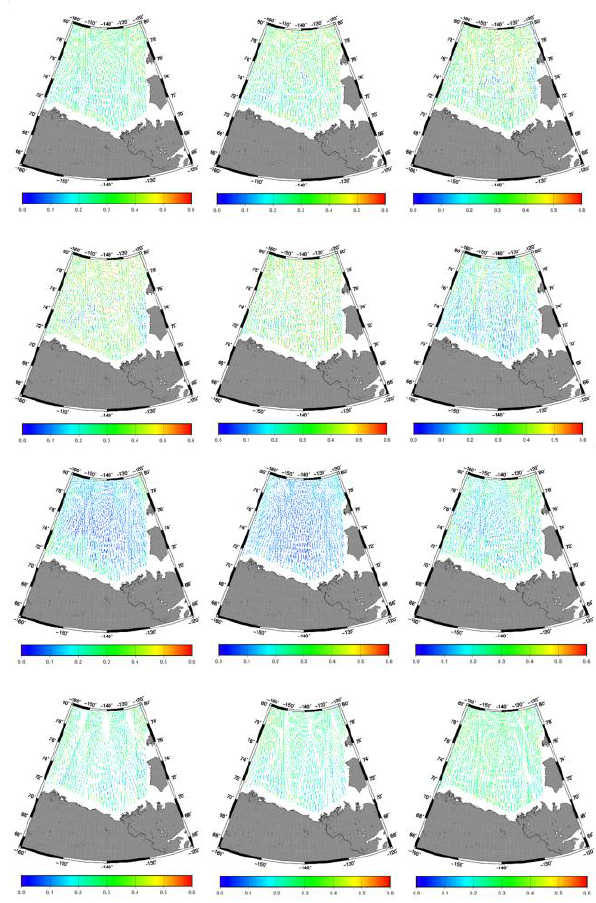
Figure 4. Sea ice freeboard distributions of Beaufort Sea from January to December in 2013 (from left to right, top to bottom)